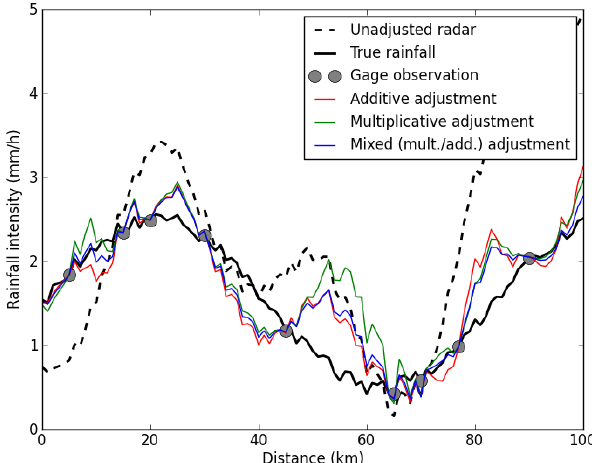
Fig. 5. A 1-dimensional example with synthetic data for illustrating different adjustment approaches in wradlib. The true rainfall was generated by combining a sine curve with white noise. Contami- nating the true rainfall with spatially variable additive and multi- plicative error terms yields the unadjusted radar observation. Three adjustment methods are then applied via wradlib.adjust – using the gage observations (grey circles) which are random samples of the true rainfall. See Fig. 6 for a verification of this example adjustment.